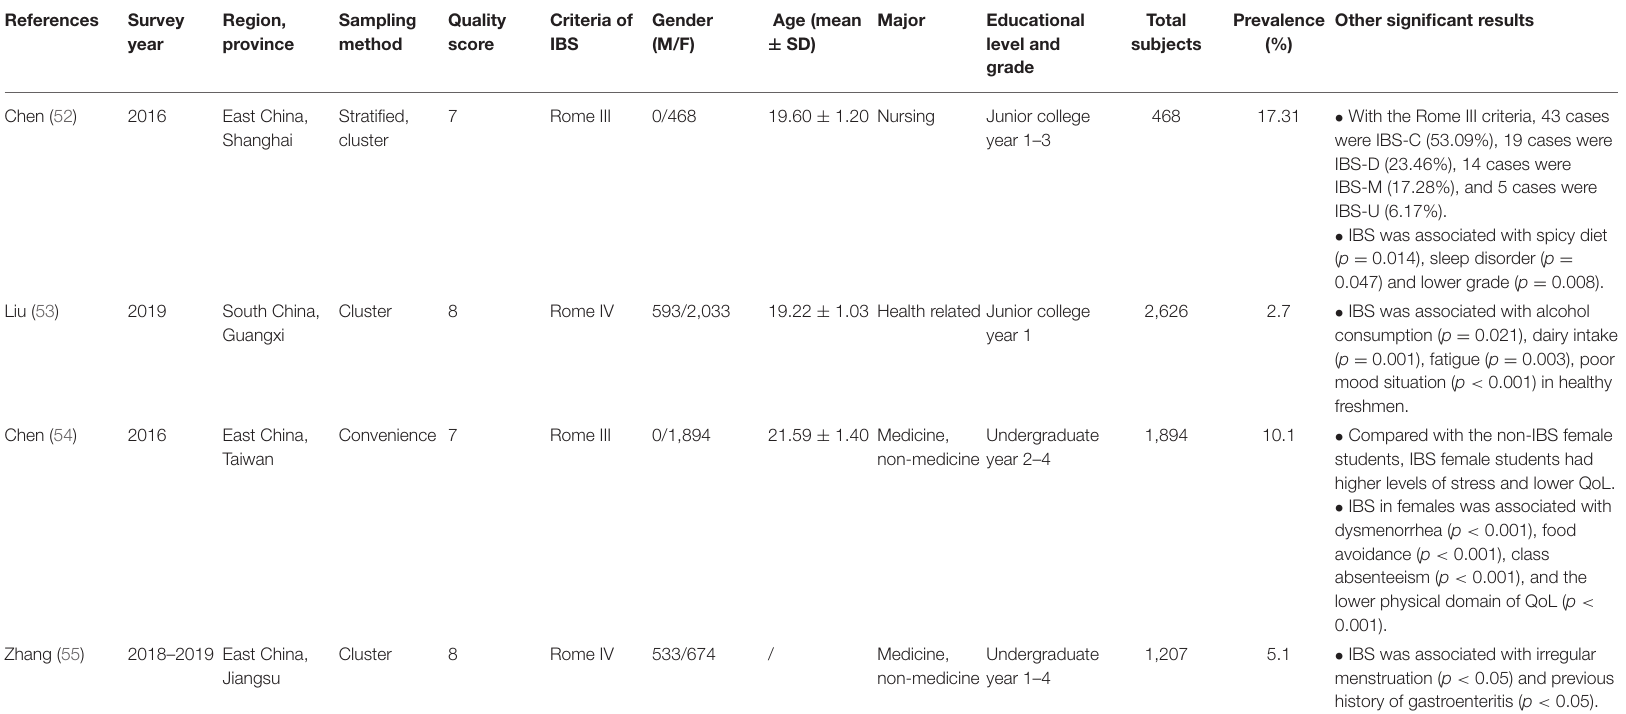
history of gastroenteritis ( p <